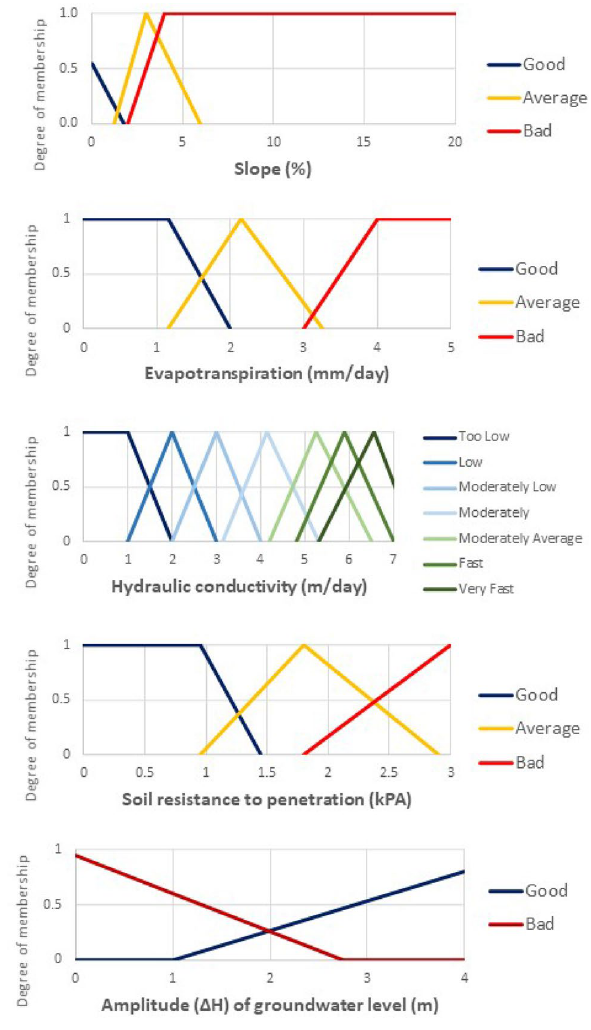
Fig. 5 Input variables and output with membership functions of triangular